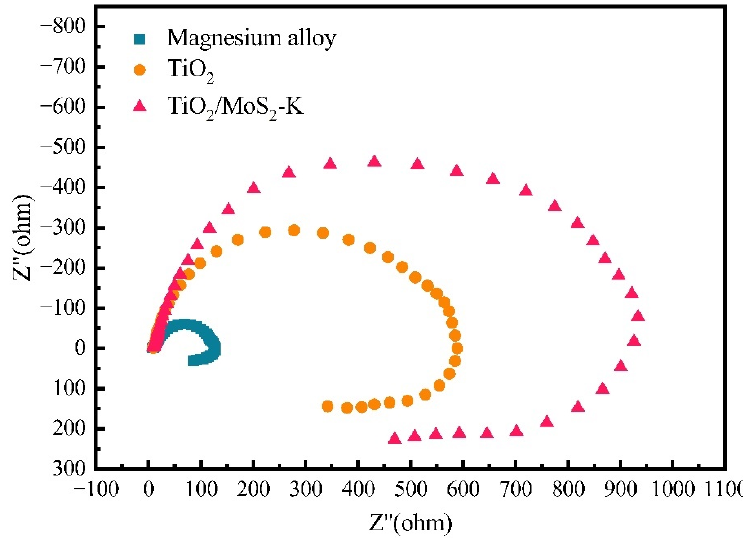
Figure 7. Electrochemical impedance spectroscopy of magnesium alloy, TiO 2 , TiO 2 /MoS 2 -K.